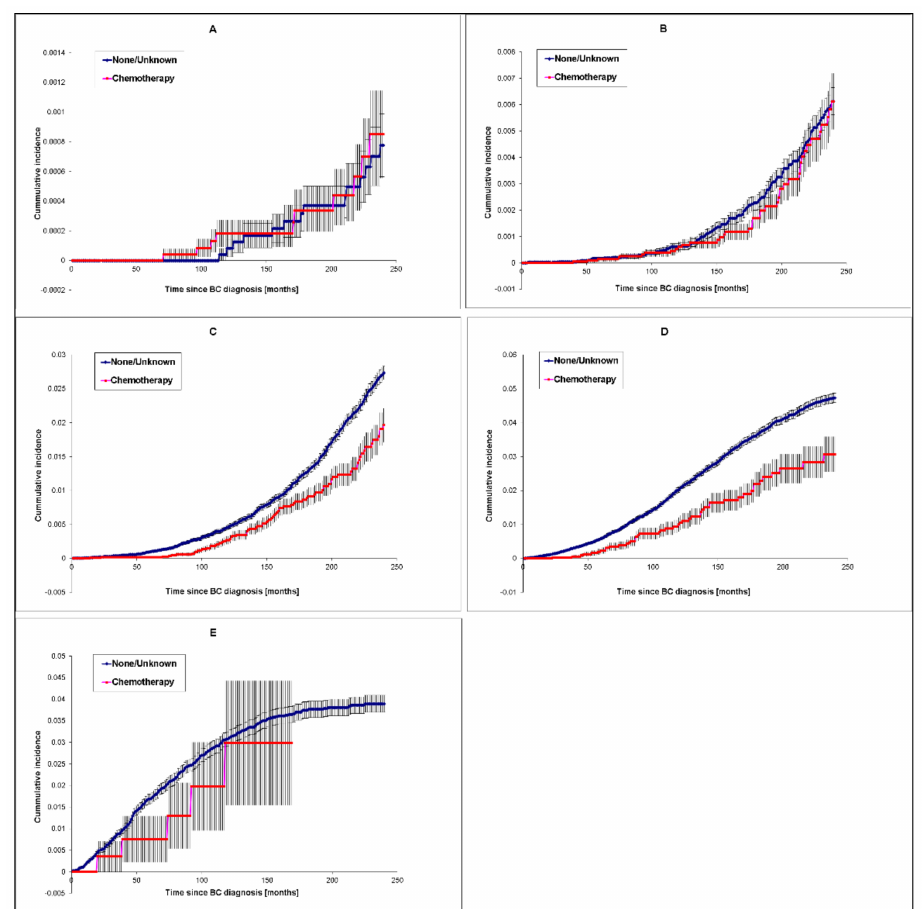
Figure 3. E ff ect of chemotherapy on cumulative incidence of AD death for white women diagnosed with breast cancer. Data for the age groups of 45–54 years ( A ), 55–64 years ( B ), (65–74 years ( C ), 75–84 years ( D ), and 85 + years ( E ) are shown. Error bars indicate standard errors